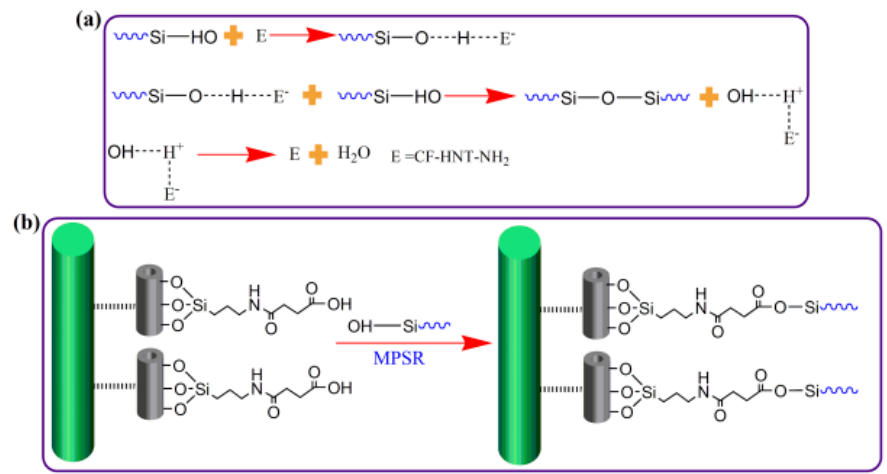
Figure 6. Schematic representation of the interfacial reaction of: ( a ) CF–HNT–NH 2 composites; and ( b ) CF–HNT–COOH composites.